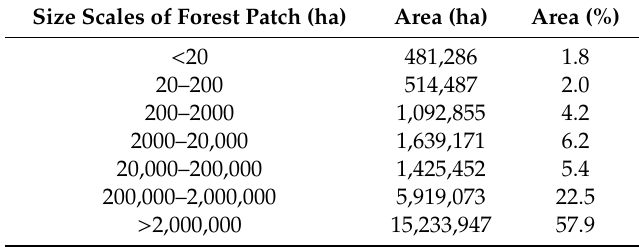
Table 2. Forest patches in the Department of Santa Cruz categorized into seven size ranges. Size Scales of Forest Patch (ha)